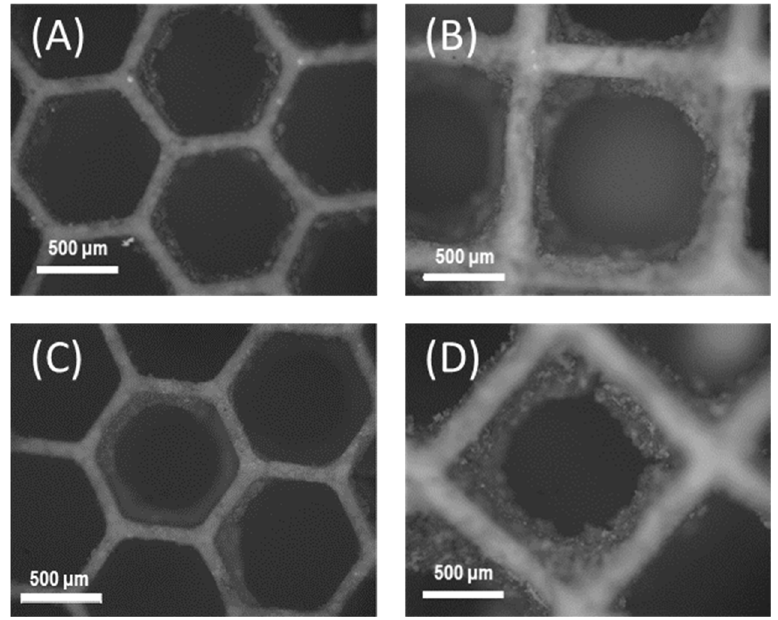
Figure 2. Optical microscope pictures of ( A ) BECTWC, ( B ), BECDOC, ( C ) PLTWC, and ( D ) PLDOC monolithic carrot samples (5× magnification).